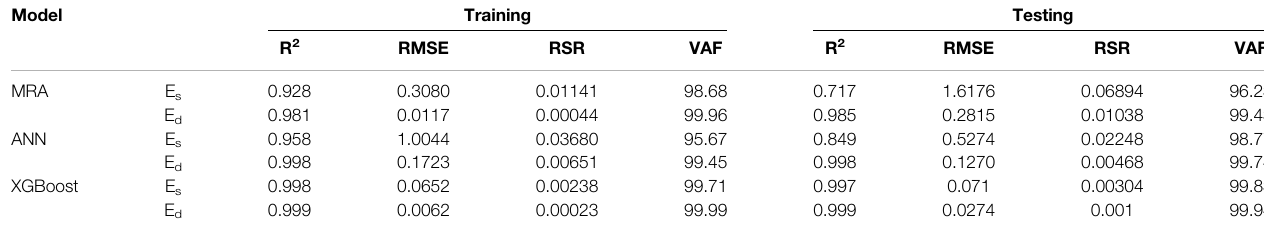
TABLE 3 | Performance criterion of the MRA, ANN, and XGBoost.